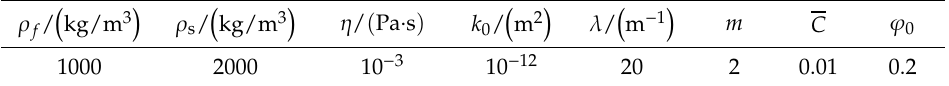
Figure 4. Schematic diagram of the model: ( a ) geometry conditions; ( b ) boundary conditions. Table 1. Parameters for numerical